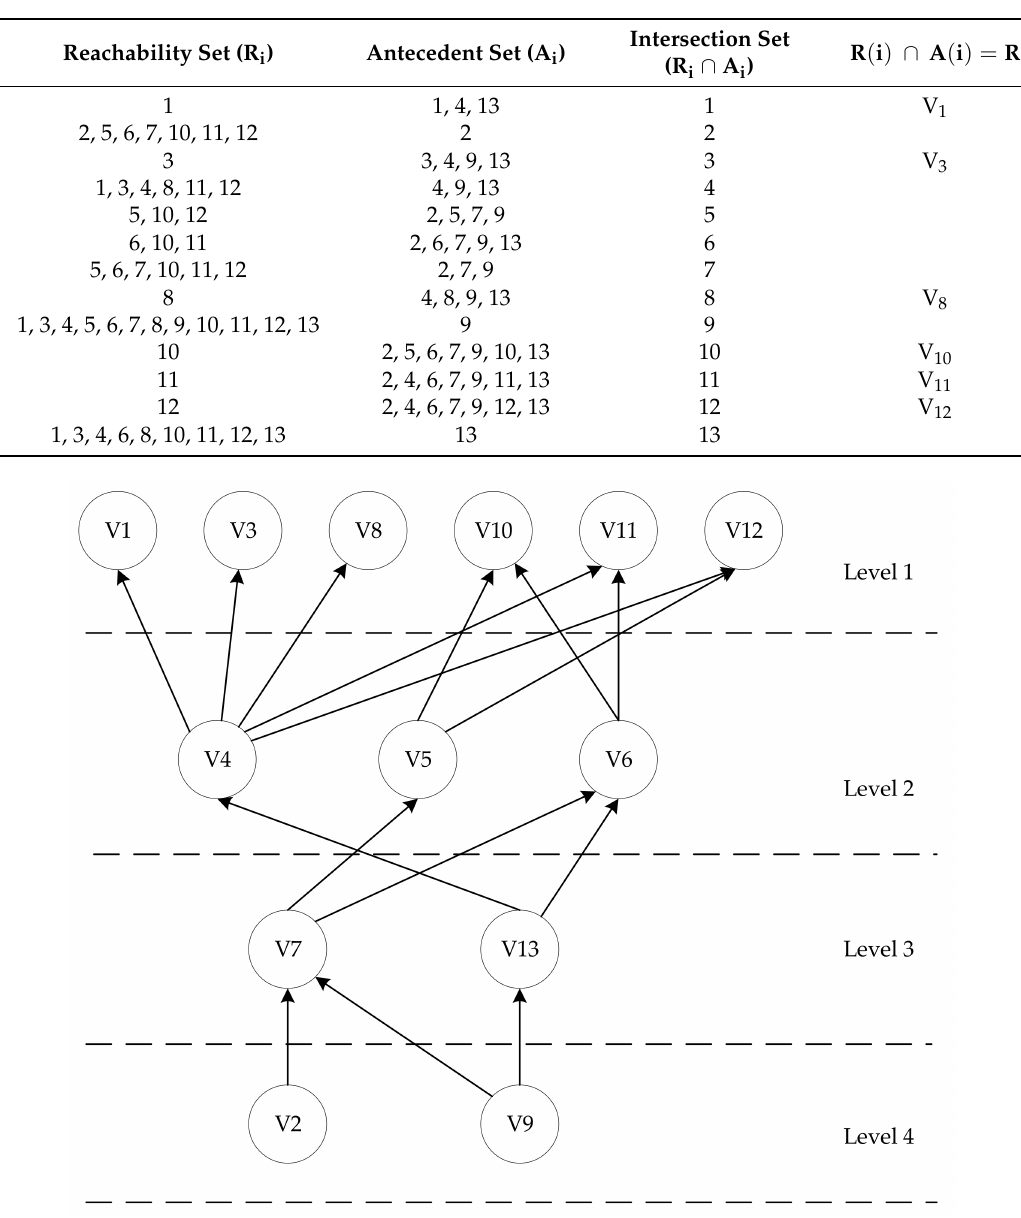
Figure 4. Hierarchical structure of urban flood